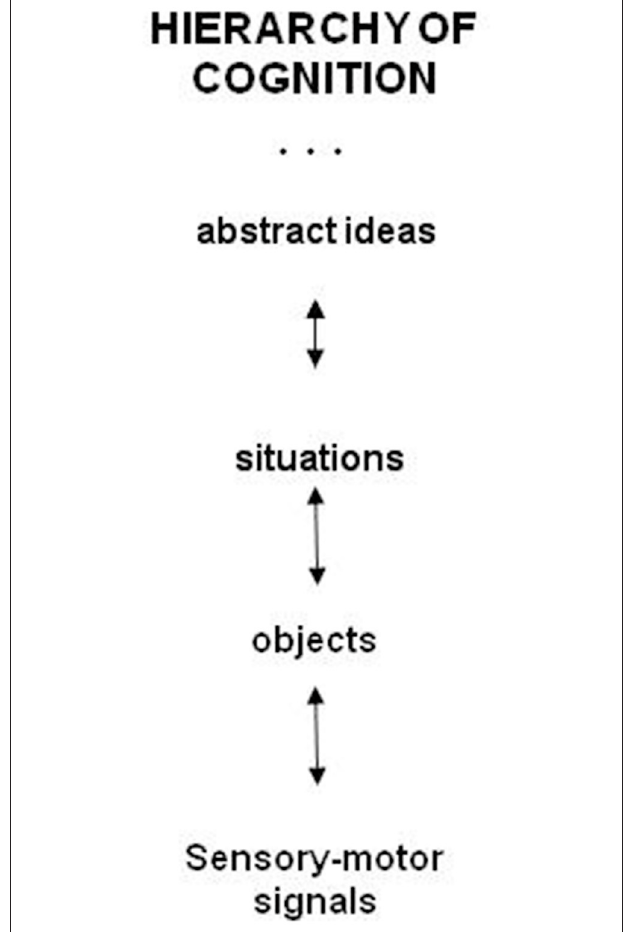
FIGURE 1 | The hierarchy of cognition. Cognition is organized into an approximate hierarchy of concepts from objects to abstract concepts and higher up to the highest cognitive concepts of the meaning and purpose. Aesthetic emotions function as motivators of learning concepts at every level, at the top of the hierarchy these are the emotions of the